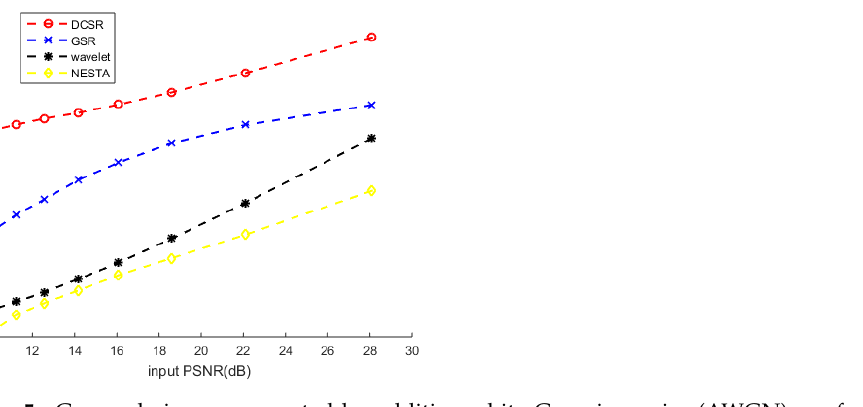
Figure 5. Grayscale image corrupted by additive white Gaussian noise (AWGN): performance analysis of four denoising methods. Table 1. Quality metric results on different algorithms for different values of noise levels.